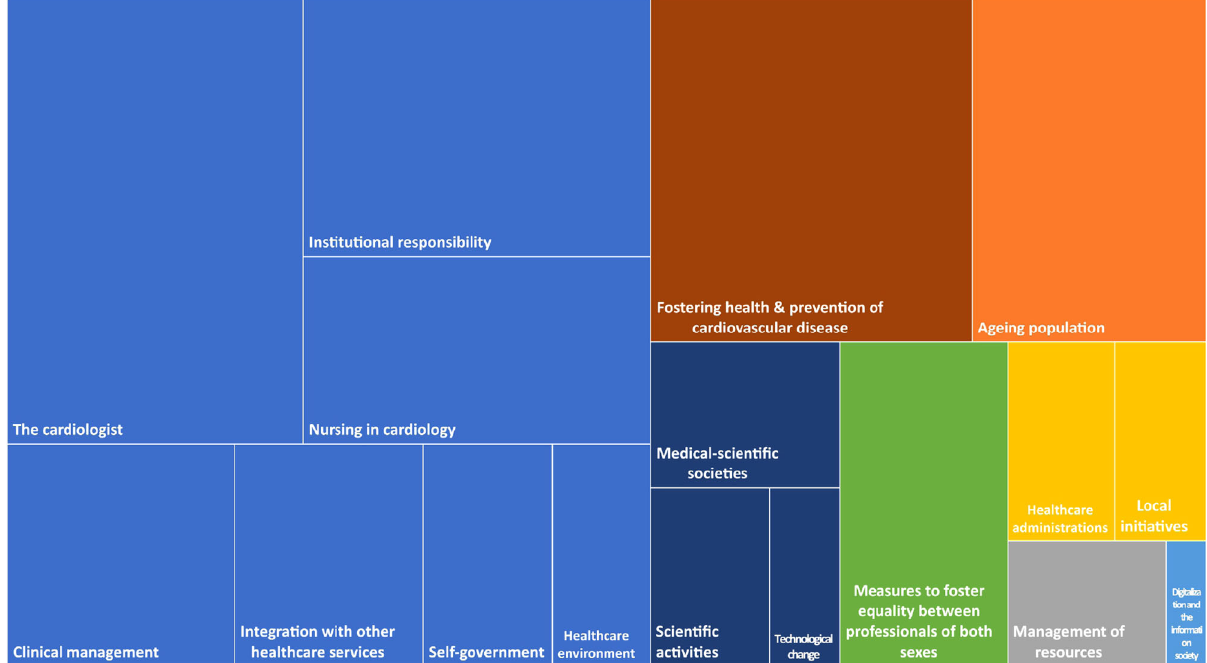
Fig. 2 Distribution of the impact of the different areas of opinion. Short description: this illustration shows at a glance the differences between the impacts of the various trends, as well as how the areas of opinion contribute to their size.